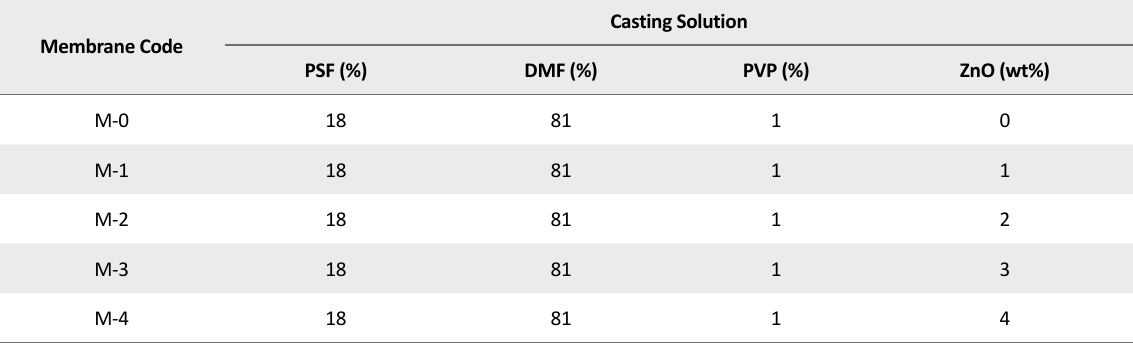
Casting Solution